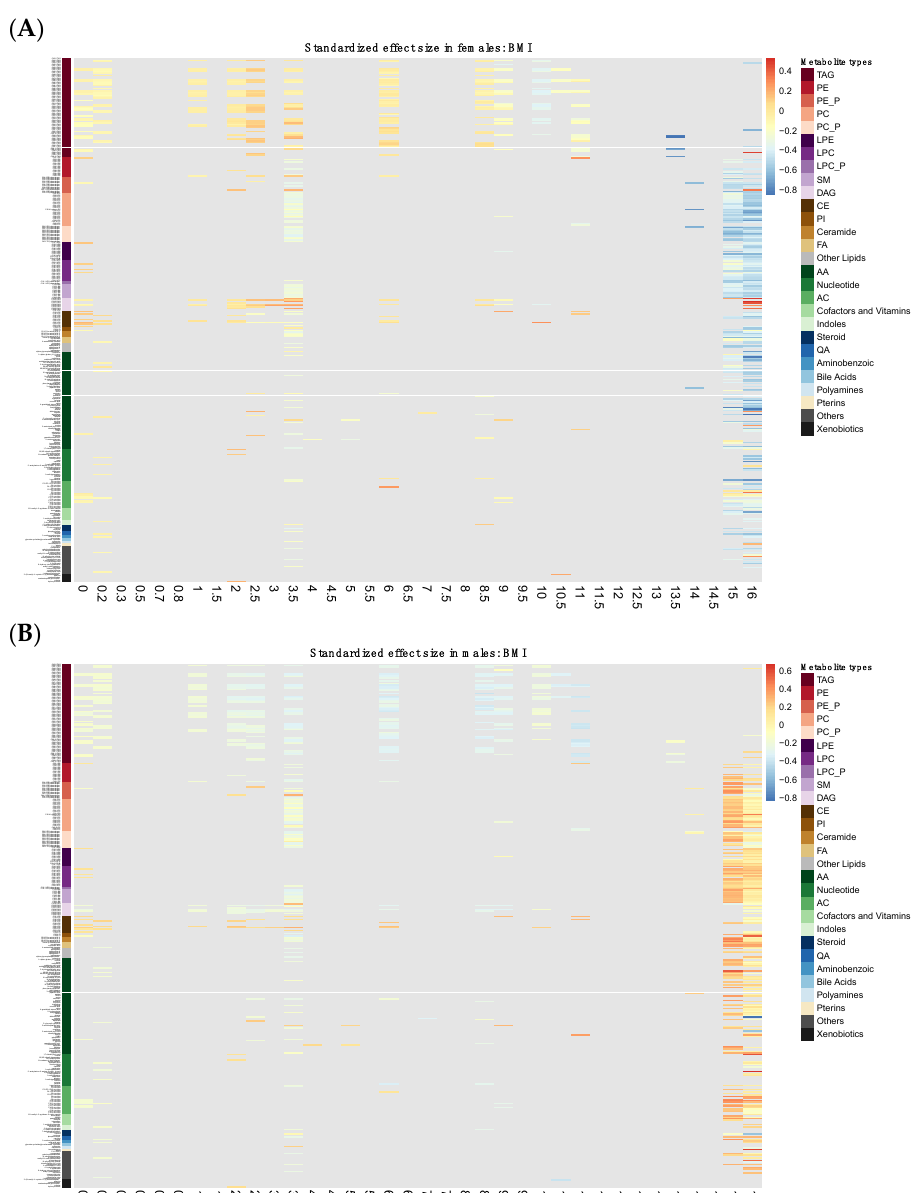
9 of 19 window. Green lines are the LOWESS smoothing curves. Potential critical growth ages (peaks in panel A) are around ages 0 (birth), 1–3.5, 6, 8–11, and ≥ 15. Heatmaps in Figure 5 display the standardized effect size for each metabolite along the 36 time-windows for males and females, respectively, while Supplementary Table S7 lists all the model results. At around birth, ages 1–3.5, and 8–11, TAGs, DAGs, and CEs showed strong correlations with BMI, corroborating the results we saw in the longitudinal